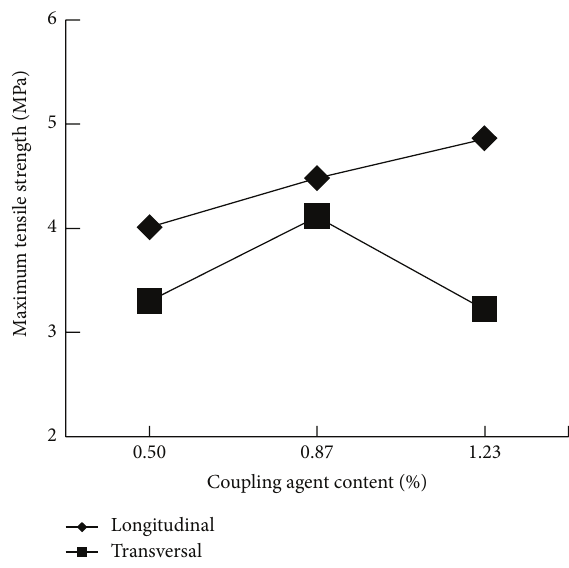
Figure 2: Behavior of maximum tensile strength against the coup- ling agent content.